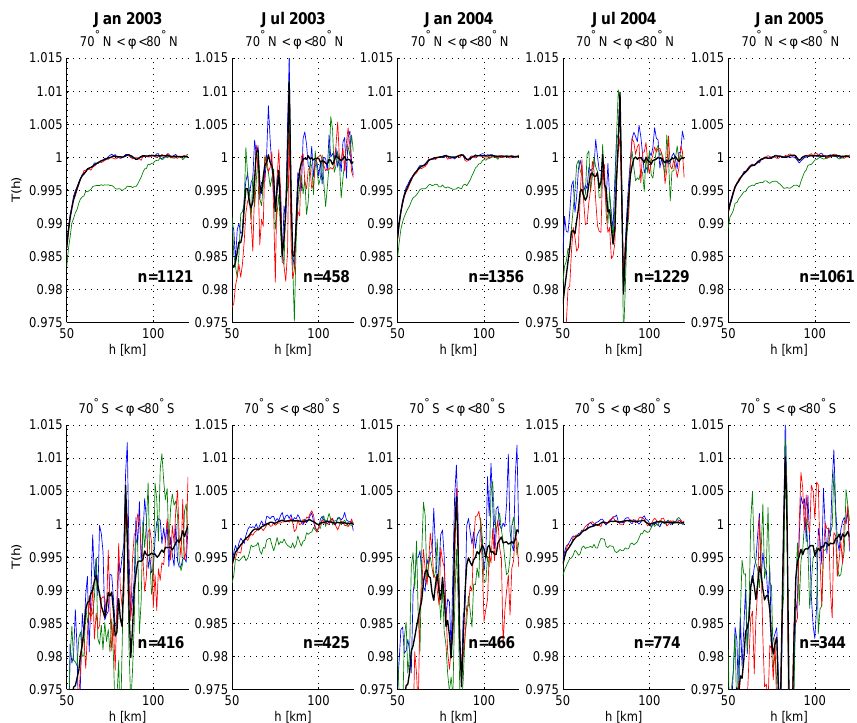
Fig. 5. Median transmittances as a function of tangent height for polar bins during the months January and July from 2003 till 2005. The number of occultations in the bin is indicated by n . In each subplot, red and blue colors correspond to control pixels (with only a smooth ozone absorption) whereas the green color represents a pixel associated with the D 2 sodium absorption that exhibits a depression due to the Na mesospheric layer. The black curve is the mean transmittance in a 20nm window around the the Na absorption region. Close to summer solstices in each hemisphere, PMC dips and “flashes” are clearly seen around 83km, for all wavelengths.